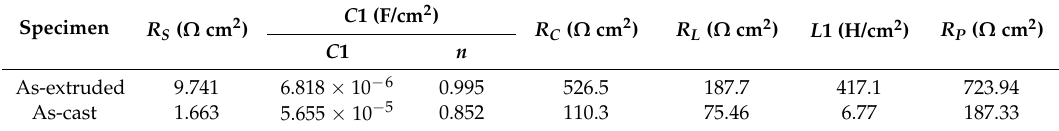
Figure 7. Equivalent circuit of the EIS (Electrochemical impedance spectrum) spectra for as-extruded and as-cast alloys. Table 2. Fitting results of the EIS of the as-extruded and as-cast alloys.